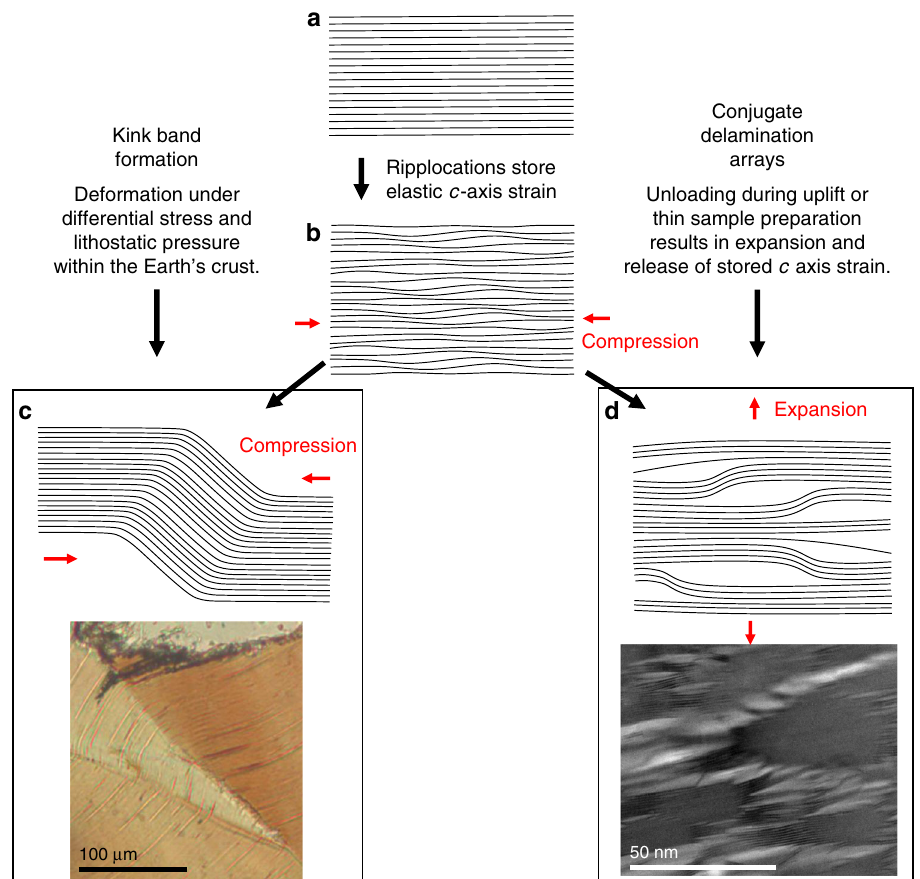
Fig. 5 Conceptual model showing how ripplocations lead to kink bands or conjugate expansion structure arrays. A pristine undeformed biotite lattice ( a ) experiences differential stress with some component of compression parallel to the basal planes. As the lattice is con fi ned this induces numerous small bulk ripplocations, which store the resulting c -axis parallel strain energy ( b ). Continued basal plane parallel compression imparts enough energy for ripplocations on different layers to migrate and merge to form a kink band between two kink band boundaries of opposite sign ( c ). The elastic c -axis strain energy becomes permanent strain on the formation of mature through-going kink bands. This may produce the kinked microstructures common in micas from viscously deformed rocks. Parts of a biotite lattice that have experienced a stress fi eld similar to b but in which kinking has not been induced still contain stored elastic c -axis strain energy in the form of ripplocations. This energy is released on thinning for TEM analysis in the form of conjugate arrays of expansion structures and delaminations, which facilitate a grain-scale c -axis parallel expansion ( d ). This is represented by the structures shown in Fig. 2 of this